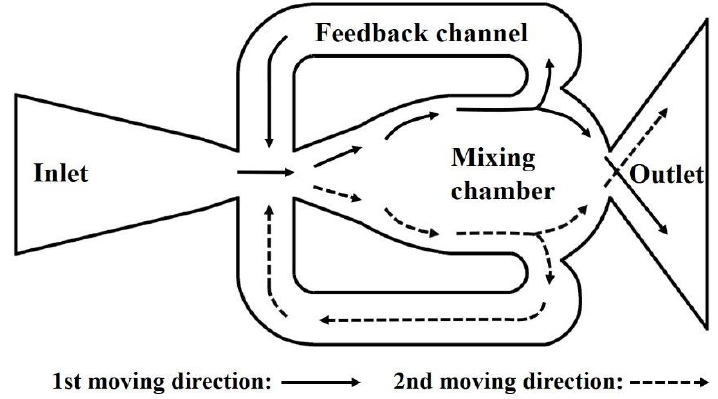
Figure 1. The mechanism of operation of a fluidic oscillator.